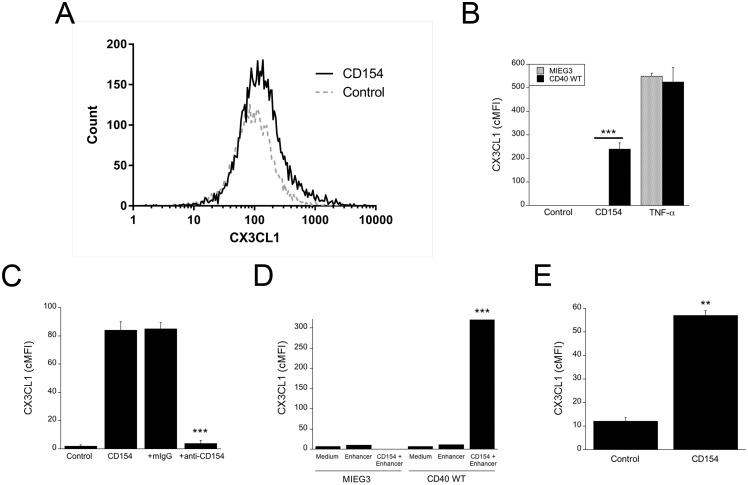
CD40 ligation upregulates membrane CX3CL1 in HAEC and HUVEC.(A–D) HAEC were transduced with MIEG3-based retroviral vector that encode EGFP or EGFP plus wt CD40. CX3CL1 expression was analyzed on transduced (EGFP+) cells. (A) Histograms show CX3CL1 expression on HAEC transduced with wt CD40-encoding retroviral vector at 24 h post-incubation with or without multimeric CD154. (B) Expression of CX3CL1 (cMFI) on gated EGFP+ cells after incubation with or without multimeric CD154 or TNF-α. (C) Transduced HAEC that express wt CD40 were incubated with multimeric CD154 with either anti-CD154 or isotype control mAb. (D) Transduced HAEC that express wt CD40 were incubated with recombinant CD154 with or without enhancer used to crosslink CD154. (E) HUVEC were incubated with or without multimeric CD154. Results are shown as mean ± SEM and are representative of 3–5 experiments. ** p < 0.01; *** p < 0.001.